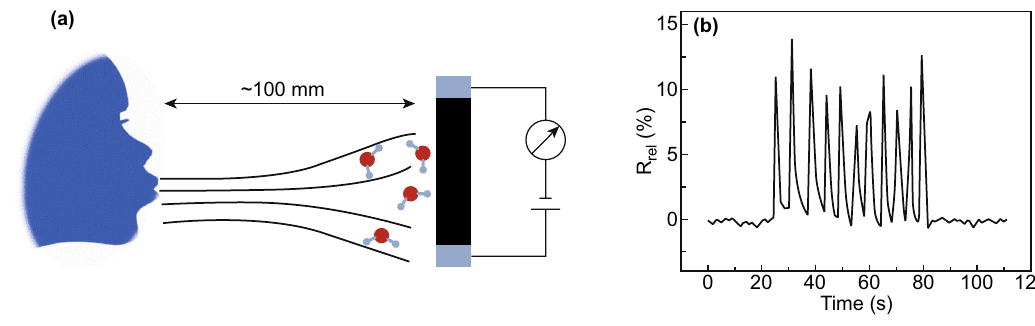
Fig. 24 a Schematic view of in-situ monitoring of human breathing cycle by NCs-rGO hybrid film (100 mm distance from the nose). b Evo- lution of ( R rel ) during inhalation and exhalation cycles. Reproduced with permission from Ref. [32] Copyright © 2018, The Royal Society of